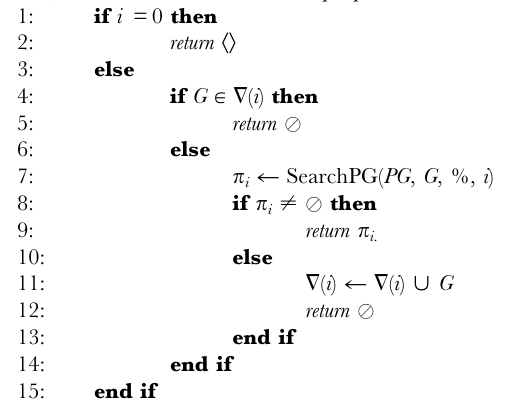
Algorithm 3 Extract(PG, G, i): Let PG be a planning graph